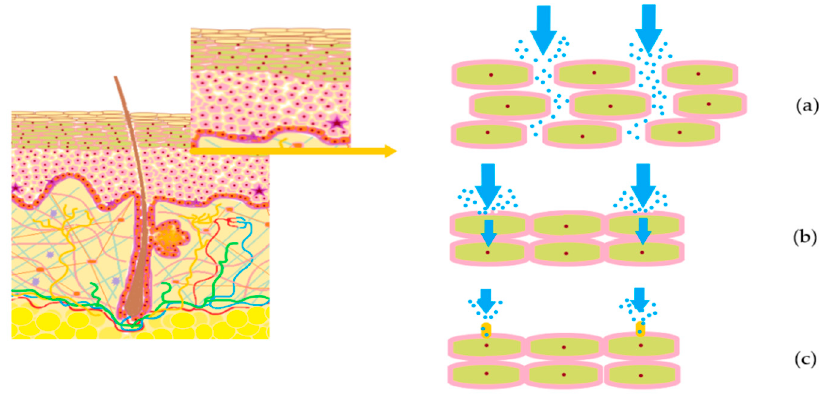
Figure 3. Pathways of particles passage for hydrophilic substances: ( a ) intercellular passage of particles between epidermal cells; ( b ) transcellular passage of particles using lipid defects in epidermal cells; ( c ) transcellular passage of particles through micropores of epidermal cells.